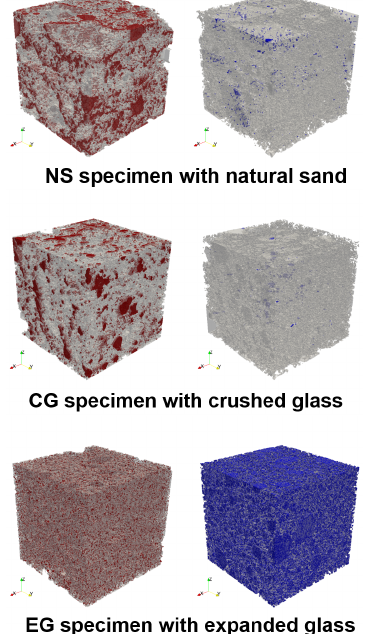
Figure8. Porestructuresofthespecimenswithdifferentaggregates(Note: ineachsub-figure,theleft Figure 8. Pore structures of the specimens with different aggregates (Note: in each sub-figure, the left figurepresentstheporeswithinthesolid(matrix)(red),whiletherightfigurepresentstheporesinside aggregateparticles(blue).) figure presents the pores within the solid (matrix) (red), while the right figure presents the pores inside aggregate particles